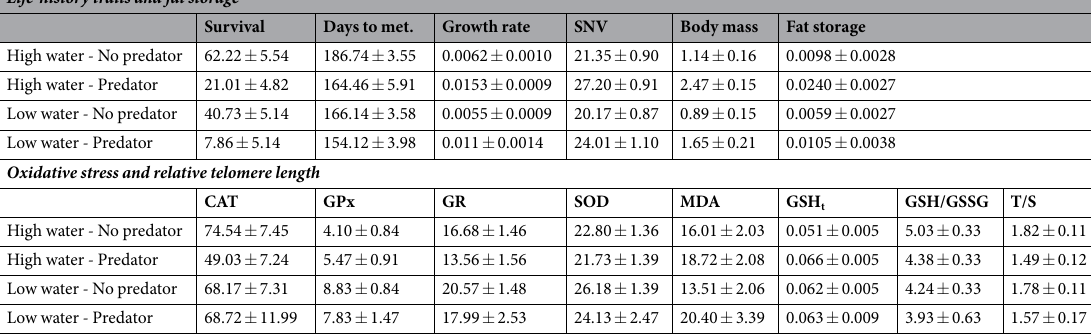
Table 1. Least square means ± standard errors of measurements obtained in surviving spadefoot toad juveniles ( Pelobates cultripes ) exposed to four environmental conditions in 500-L tanks. The variables measured were: survival (%), days to metamorphosis (days to reach 46 Gosner stage from the egg), growth rate (g/day of development), snout-to-vent length (SNV; mm), and body mass (g). Fat storage was also measured (g). Moreover, we measured the following physiological parameters: catalase activity (CAT; U/mg total protein), glutathione peroxidase activity (GPx; mU/mg total protein), glutathione reductase activity (GR; mU/mg total protein), superoxide dismutase activity (SOD; U/mg of total protein), malondialdehyde (MDA; nmol/ml), reduced glutathione (GSH; mM), the ratio of reduced to oxidized glutathione (GSH/GSSG), and the relative telomere length (T/S